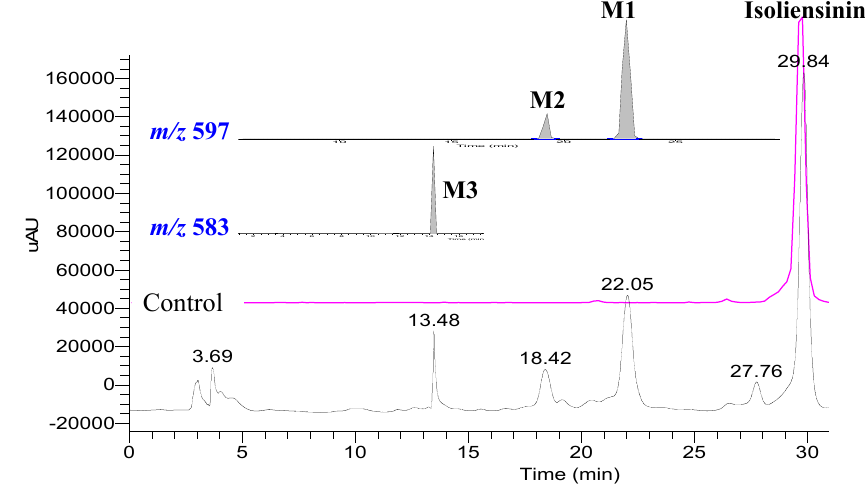
Figure 1. HPLC-UV-ESI-MS profiles of the microsomal metabolites of isoliensine. The UV chromatogram was recorded at 280 nm, and selected ion chromatograms were pre-set at m/z 583 and 597 using data-dependent mode. Pink line shows the chromatogram of the control sample in the absence of NADPH.